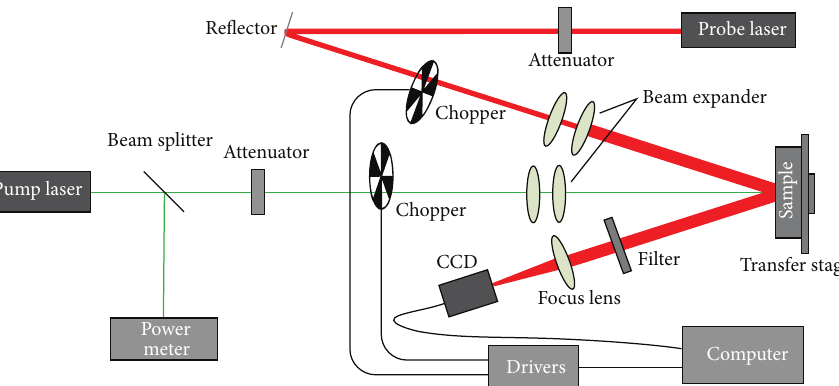
Figure 2: Schematic diagram of stroboscopic surface thermal lensing and signal